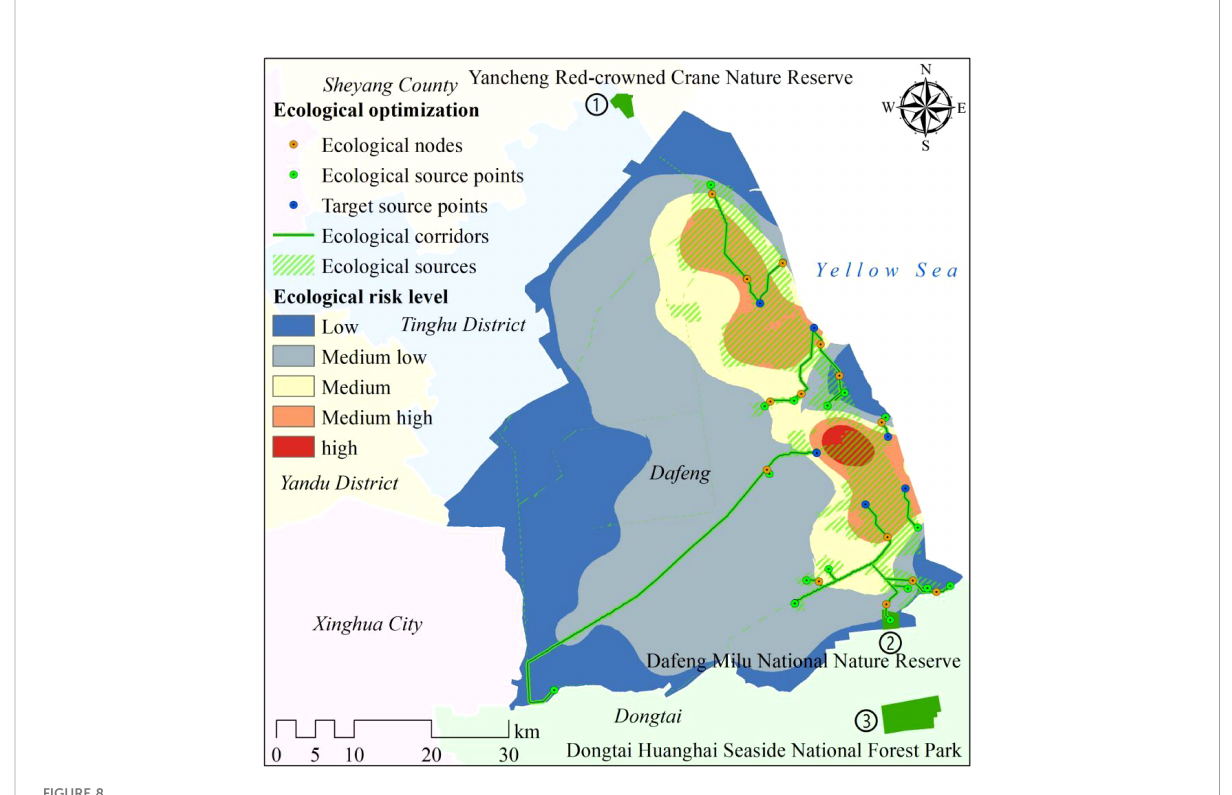
FIGURE 8 Ecological risk assessment and landscape pattern optimization